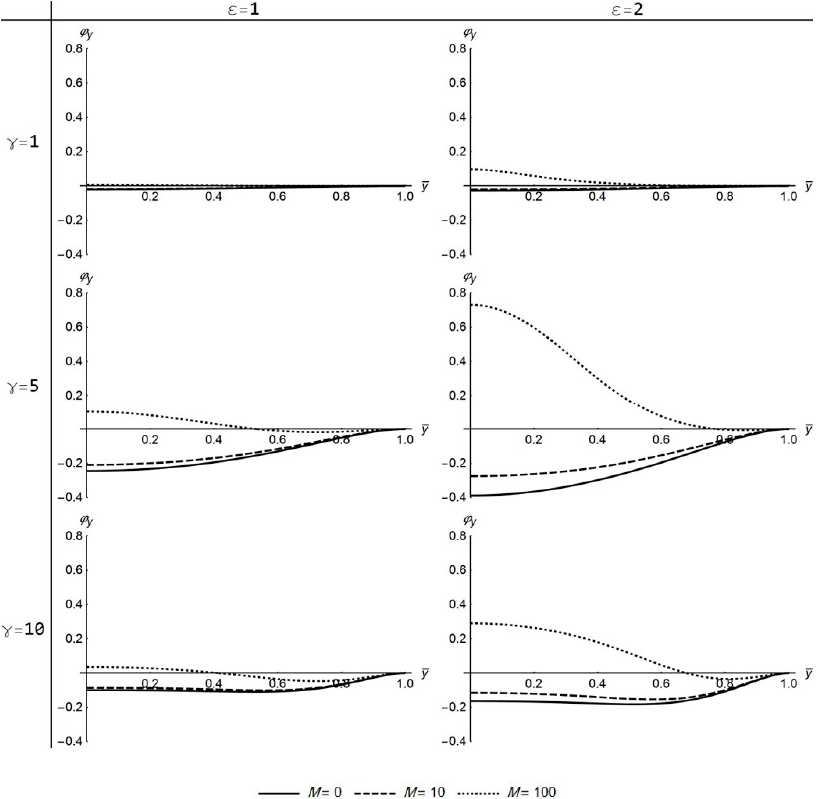
Figure 13. The profiles of ϕ y for different values of the ε , γ , and M parameters (parallel case).